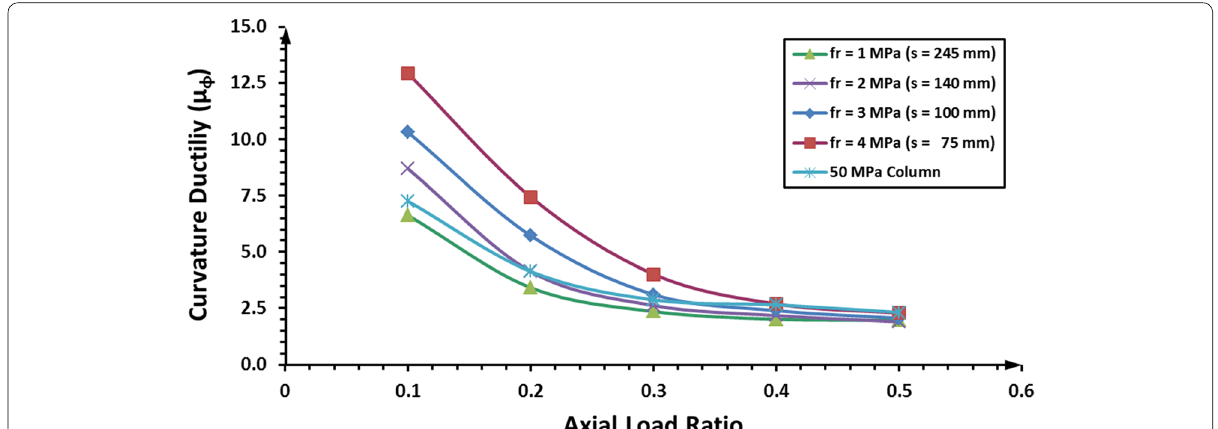
Fig. 4 Curvature ductility of VHSC columns ( µ φ ) ( ρ l